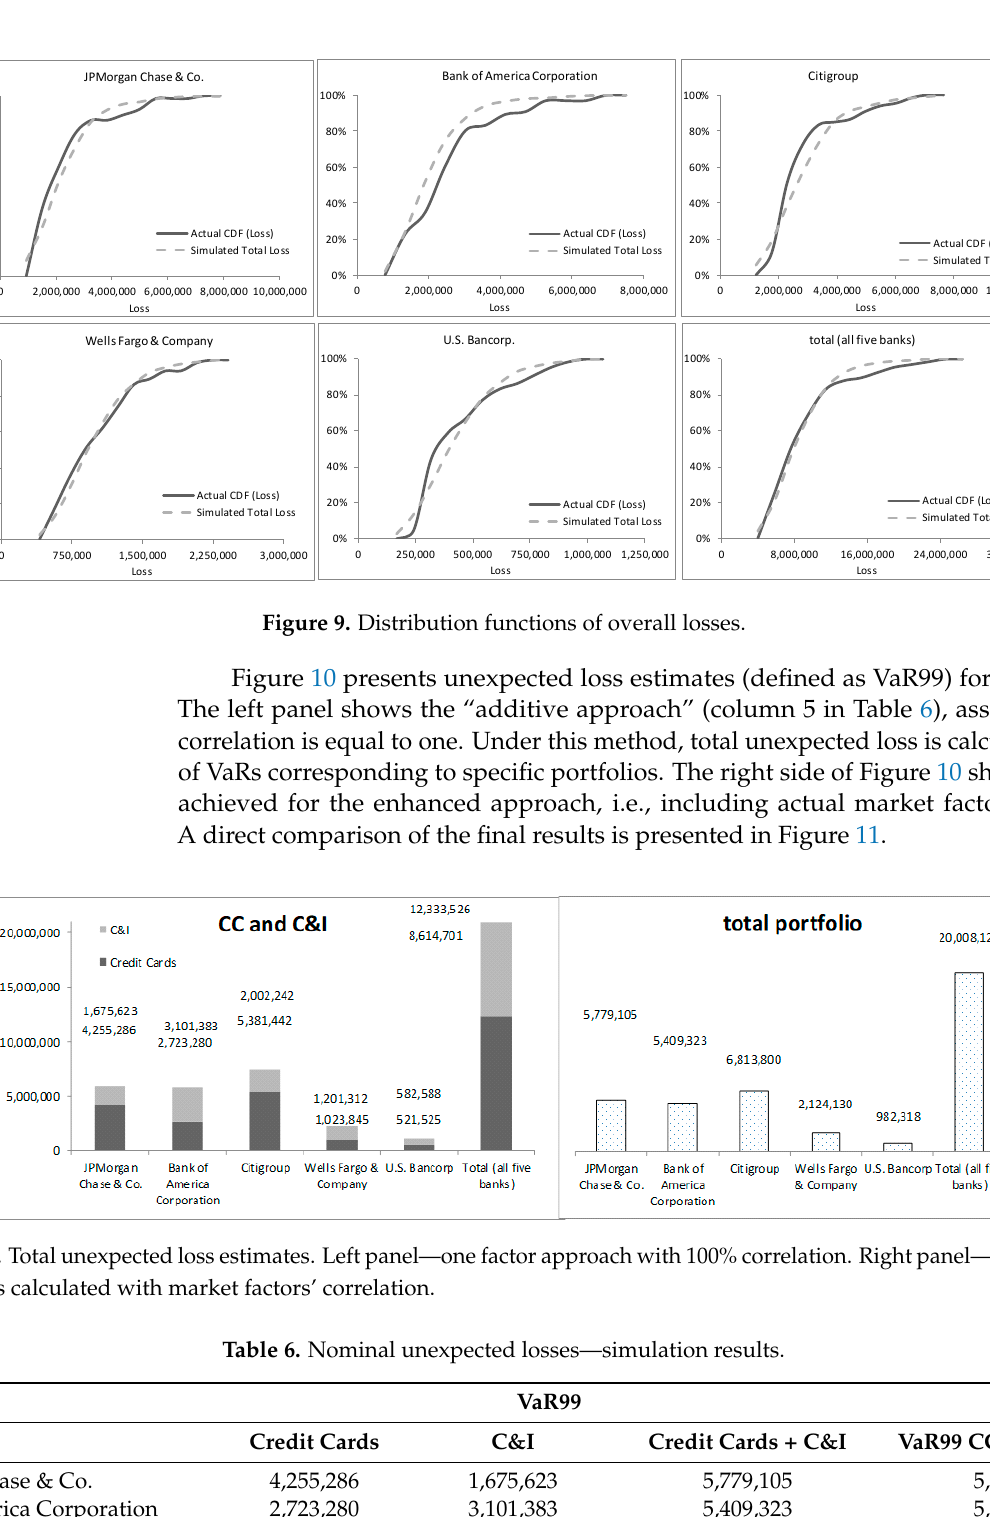
Figure 11. Unexpected losses comparison. As mentioned in the first part of this paper, the total unexpected loss also depends on market factors’ correlation. The lower the correlation, the larger the ‘diversification effect’ and the lower the capital requirements. However, the composition of the portfolio (credit cards outstanding vs. C&I outstanding) may efficiently disrupt expected benefits. A high imbalance may reduce the ‘diversification effect’ even though the correlation is low.